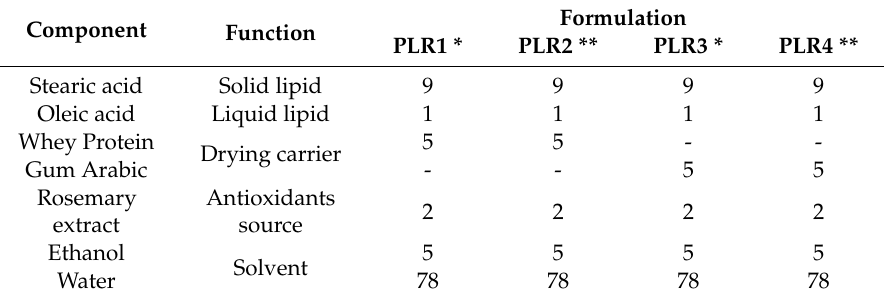
Table 1. Composition of the lipid systems containing R. o ffi cinalis lyophilized extract (% w / w ). Component